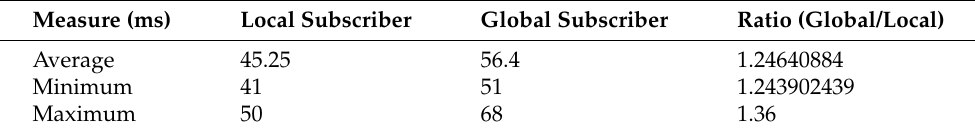
Table 2. Average/minimum/maximum delay of messages to local and global